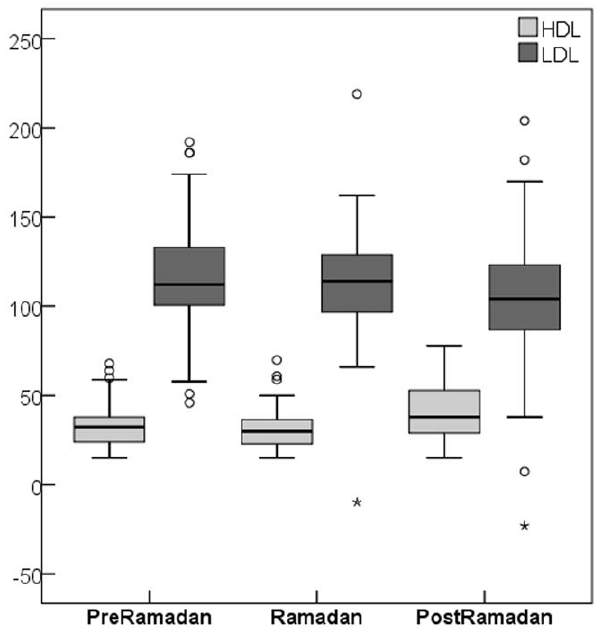
Figure 1. Box plot chart showing the progressive changes in HDL-C (light gray boxes) and LDL-C (dark gray boxes) over the time points.